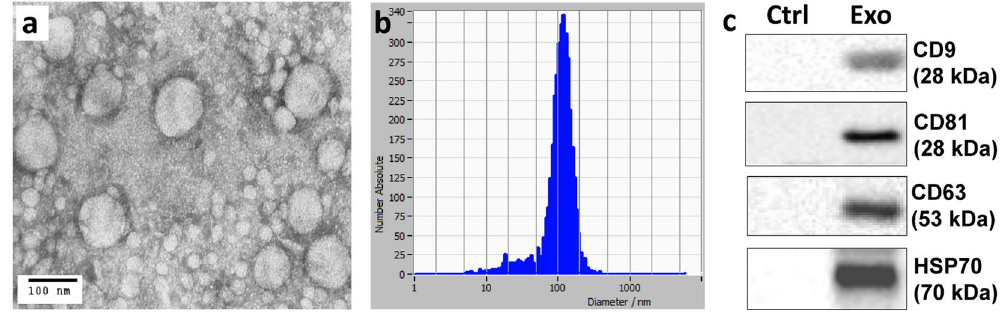
Figure 1. Characterization of exosome fractions isolated from plasma. Morphological characterization of plasma exosome fractions by transmission electron microscopy (a) and vesicle size distribution measured by nanoparticle tracking analysis (NTA) (b) from one representative HIV-negative subject. (c) Detection of exosome markers CD9, CD81, CD63, and HSP70 in plasma exosome fractions by immunoblotting (25 μ g protein/lane) in control (Ctrl) (no exosome fraction) and plasma exosome fraction